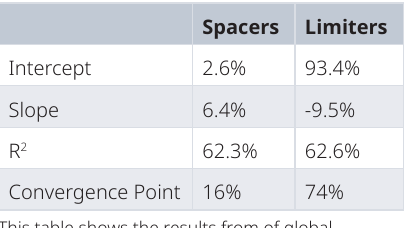
Table 1. Global regression results for spacers and